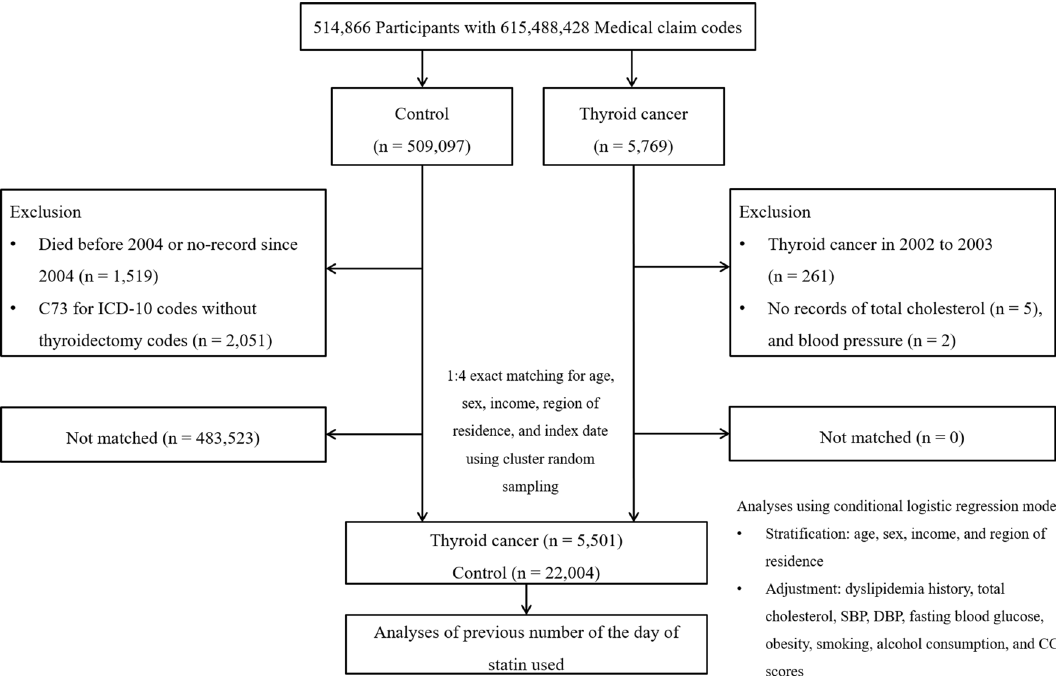
Figure 1. A schematic illustration of the participant selection process that was used in the present study. Of a total of 514,866 participants, 5501 thyroid cancer participants were matched with 22,004 non-thyroid cancer participants for age, sex, income, and region of residence. DBP diastolic blood pressure, SBP systolic blood pressure. Thyroid cancer: the thyroid cancer group comprised participants assigned the C73 ICD-10 code who underwent